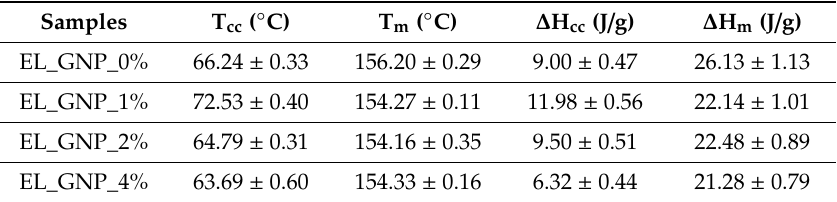
Figure 3. Representative second heating thermographs for EL_GNP_0% ( a ), EL_GNP_1% ( b ), EL_GNP_2% ( c ) and EL_GNP_4% ( d ) matrices at a heating rate of 2 K/min. Table 2. Thermal data from differential scanning calorimetry (DSC) measurements (second heating) for neat and composite matrices ( n = 3).